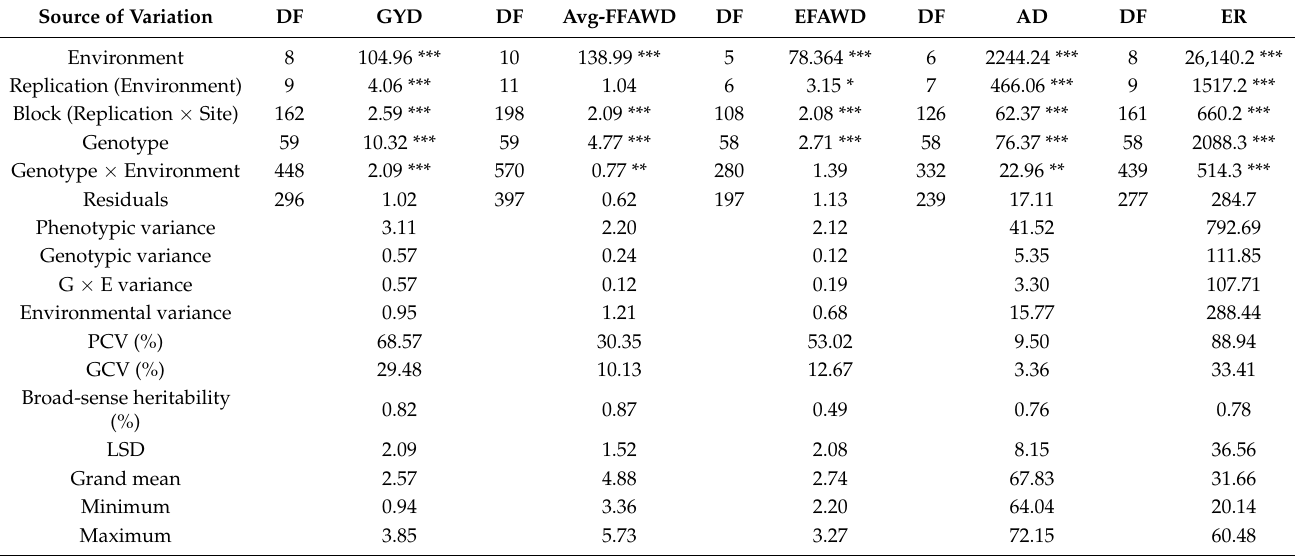
Table 3. Analysis of variance for leaf and ear fall armyworm damage scores and selected agronomic traits of commercial cultivars and experimental hybrids under natural fall armyworm infestation sites in Zimbabwe, during the 2019 and 2020 summer seasons.